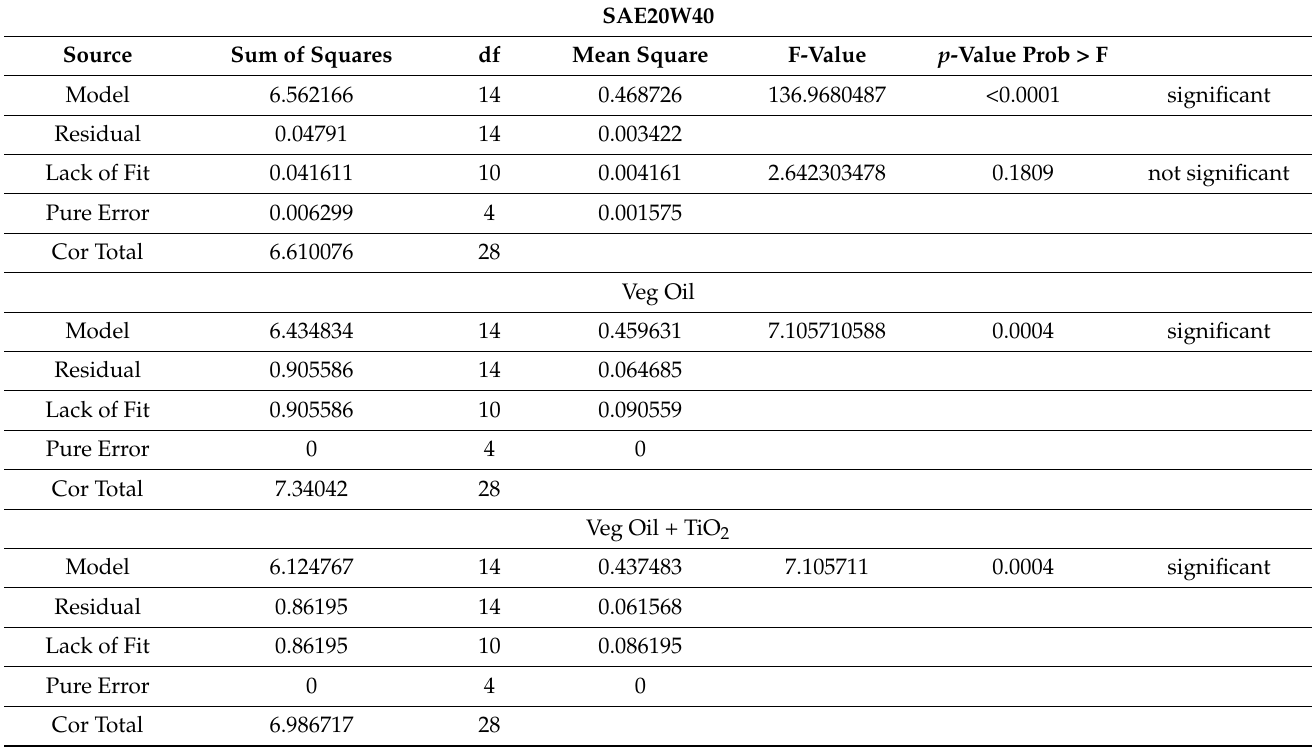
Table 8. ANOVA for surface roughness.